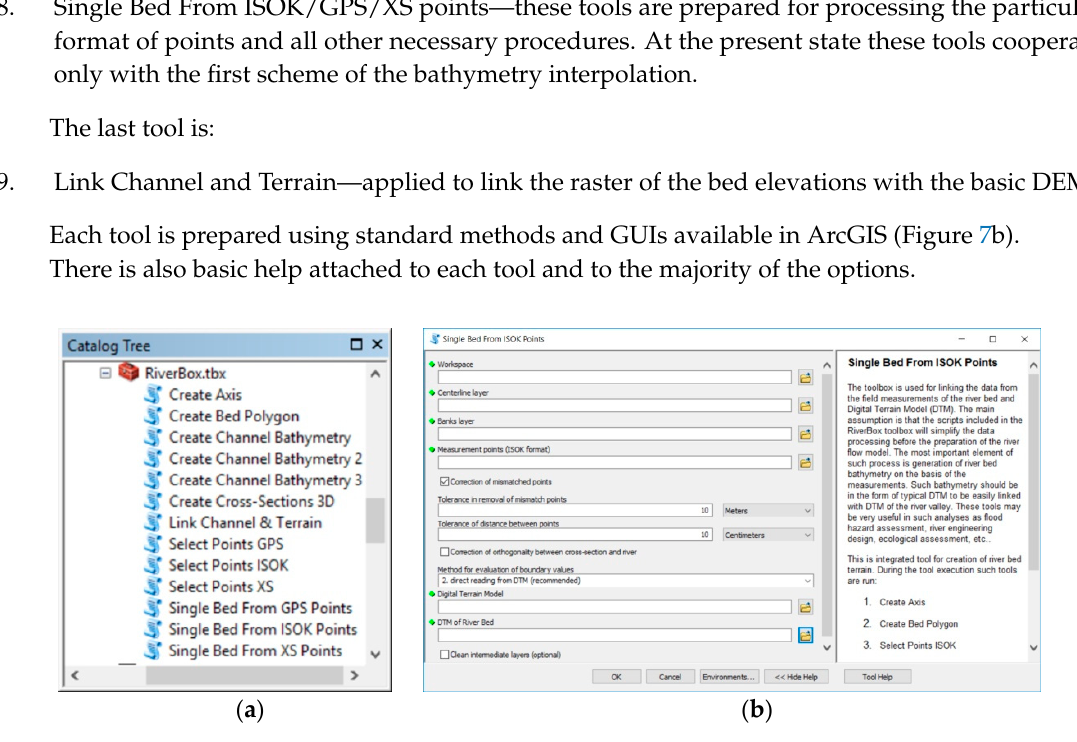
Figure 7. RiverBox presentation: ( a ) view of the toolbox in the Catalog Tree; ( b ) example of the tool interface with basic help.